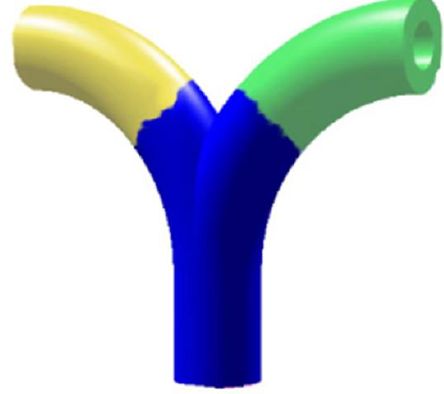
Figure 3. K-means clustering meaningful partition of the model.